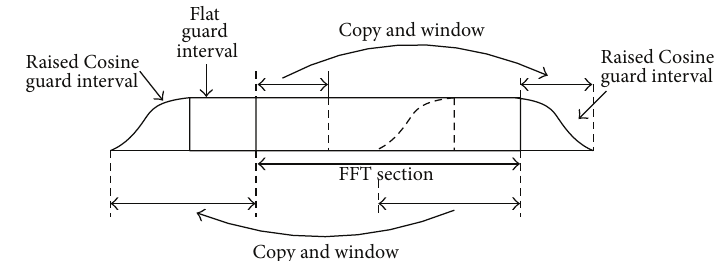
Figure 11: OFDM symbol with GI and window.